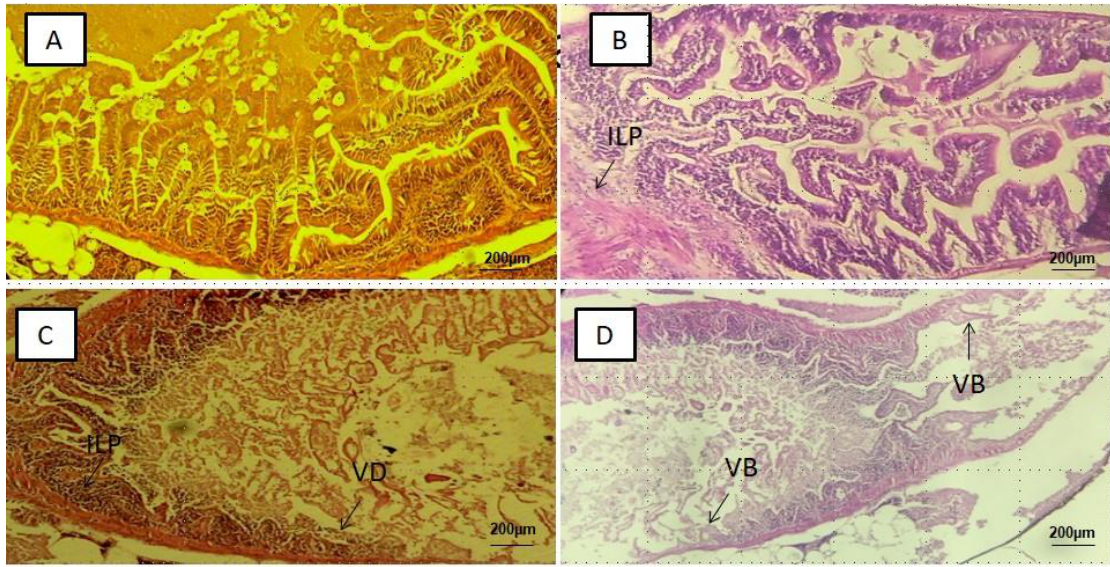
Figure 2. Representative photomicrograph of intestine: ( A ) Control group with no abnormality, ( B ) MP-LOW group showing inflammation of lamina propria (ILP), ( C ) MP-MED group showing inflammation of lamina propria (ILP), and villi destruction (VD) and ( D ) MP-HIGH group showing villous blunting (VB).